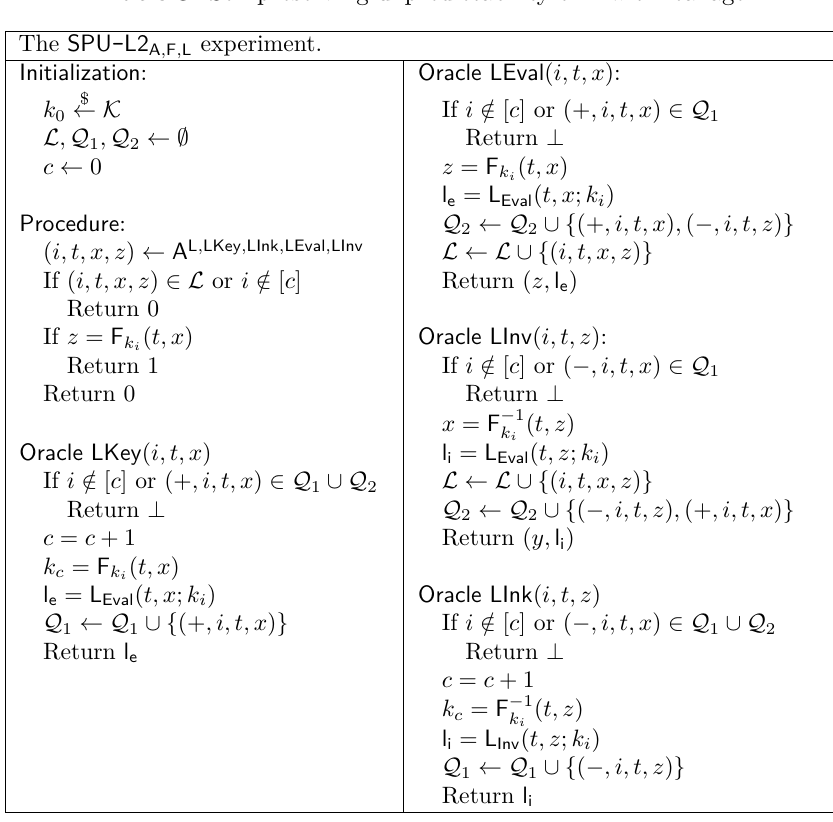
Table 5: Self-preserving unpredictability of F with